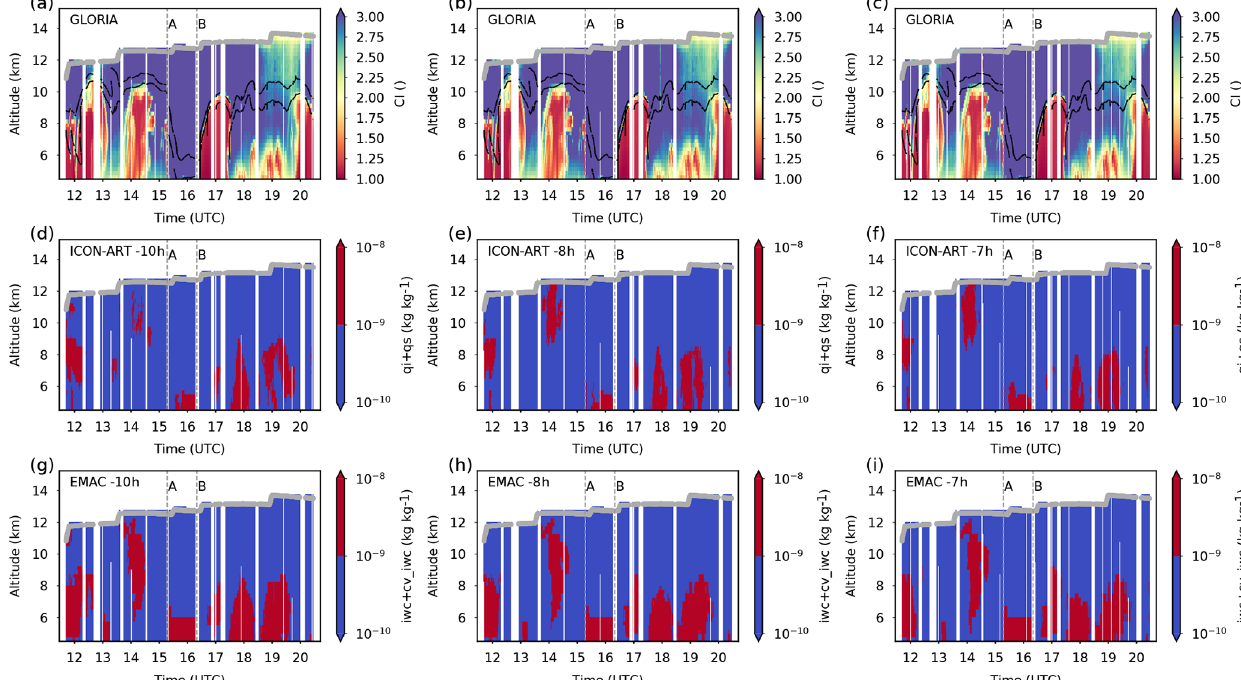
Figure A1. Same as Fig. 5, but model data (ICON-ART and EMAC) have been sampled with a constant time offset of − 10, − 8 and − 7h during the interpolation to the GLORIA geolocations along the